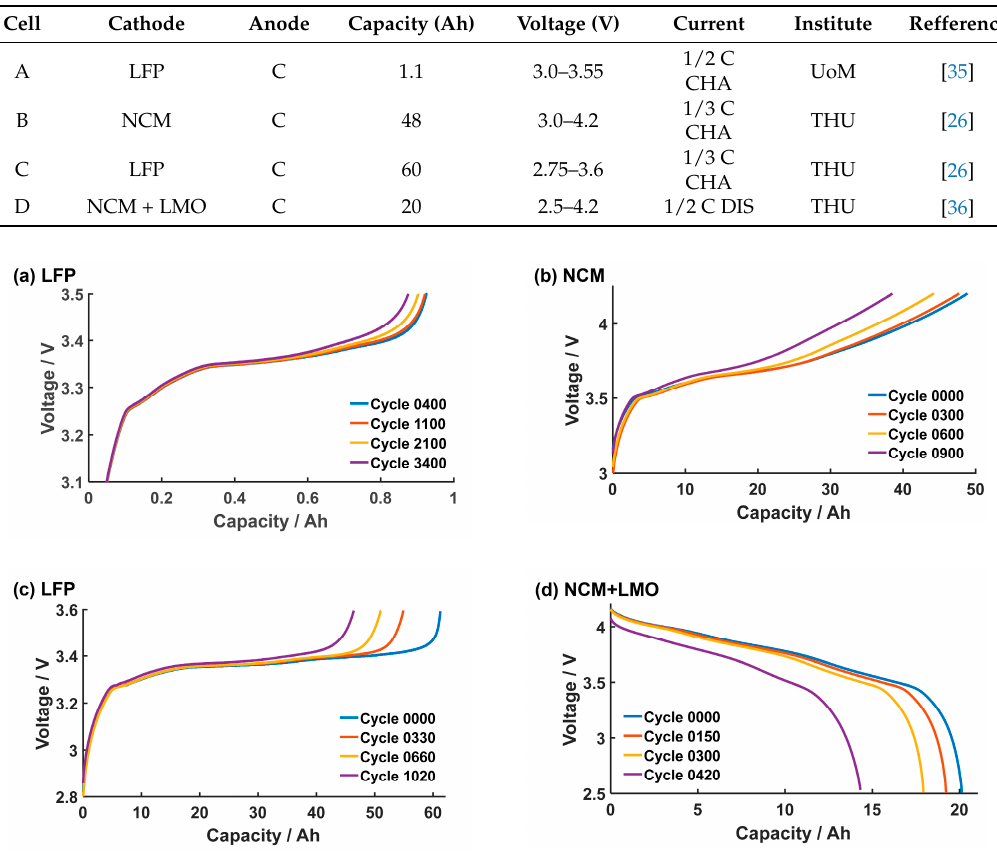
Figure 1. The voltage profile for cells with different cycle numbers. ( a ) Battery A, charge; ( b ) battery B, charge; ( c ) battery C, charge; ( d ) battery D, discharge .